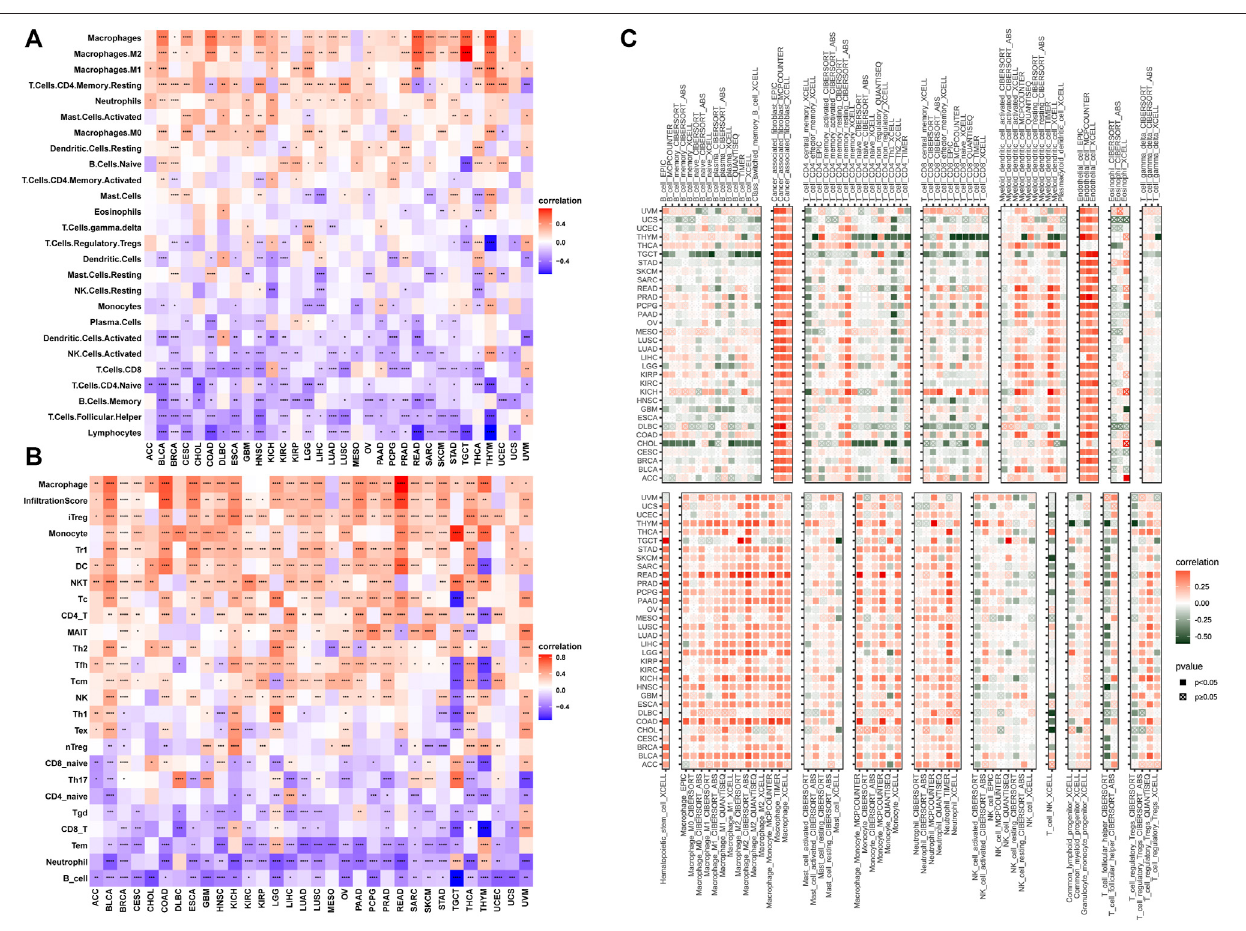
FIGURE 5 | Angiogenesis and immune cell in fi ltration analysis (A – C) : Most of the cancer types showed signi fi cant positive associations between angiogenesis scores and in fi ltration levels of macrophages, NK cells, as well as CD4 + T cells).